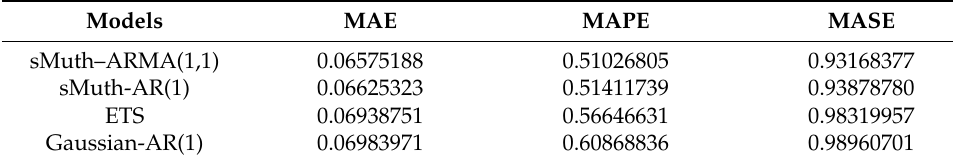
Table 5. Measures of prediction for the time series models used. Models MAE